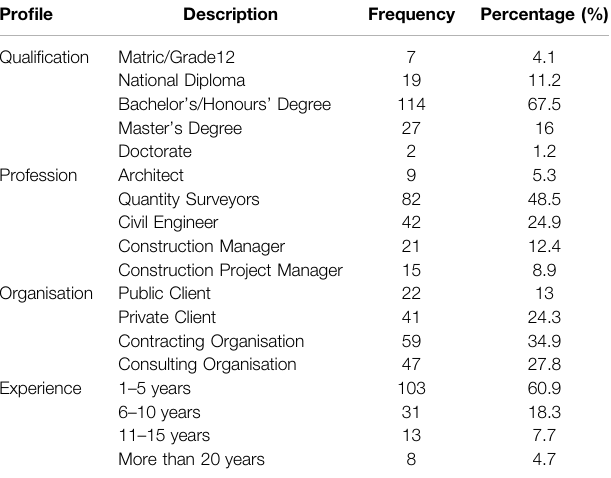
TABLE 3 | Respondents ’ pro fi le summary.